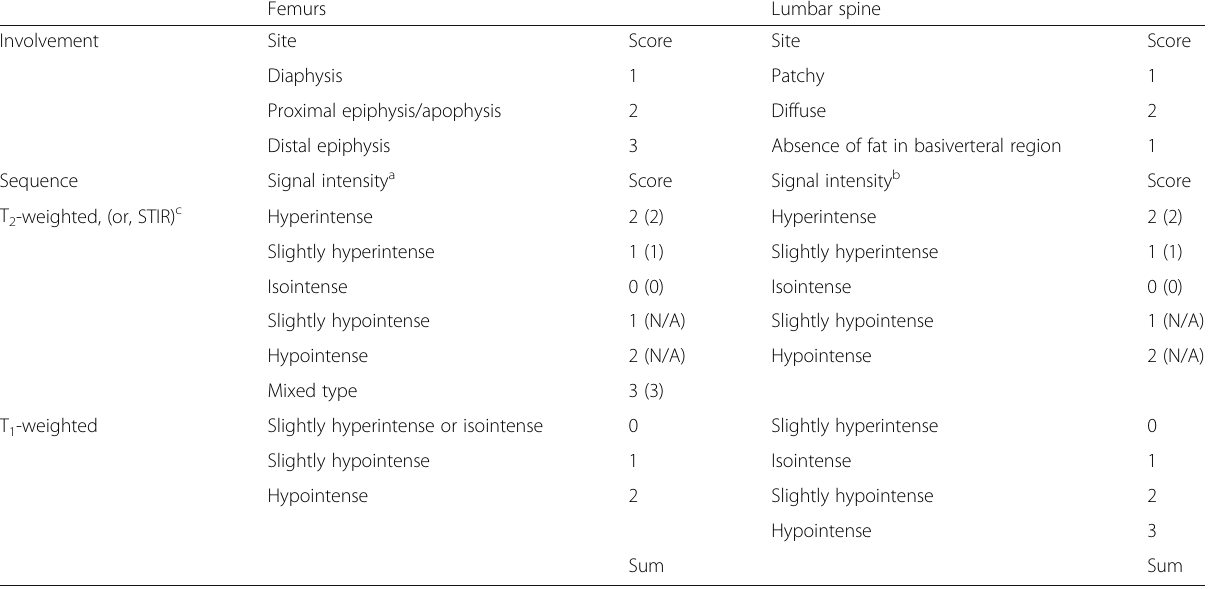
Table 6 Bone marrow burden (BMB)